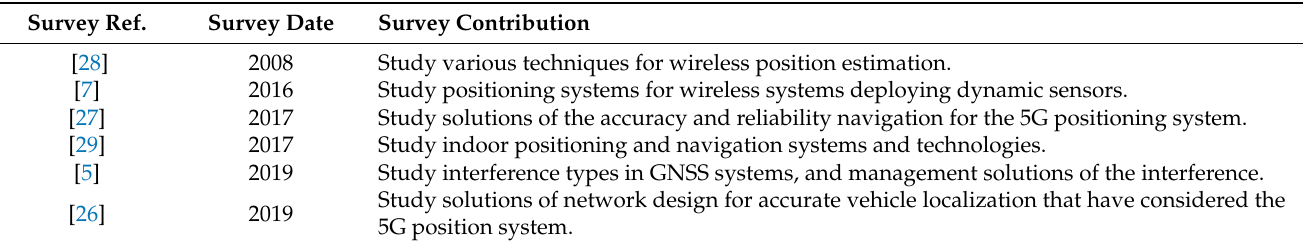
Table 1. Recent surveys tackling similar topics to our